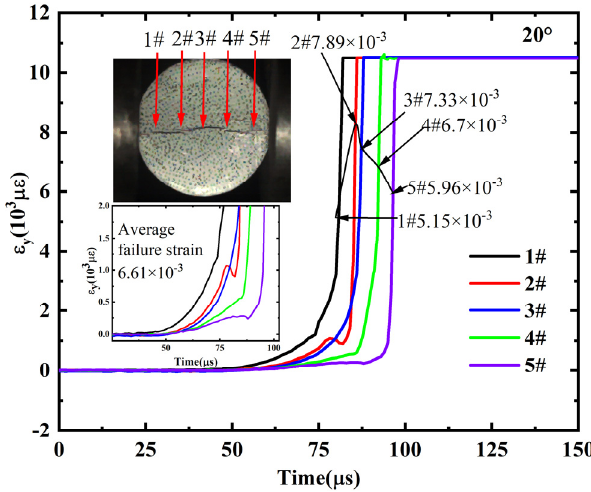
Figure 15. Strain history of the crack opening.